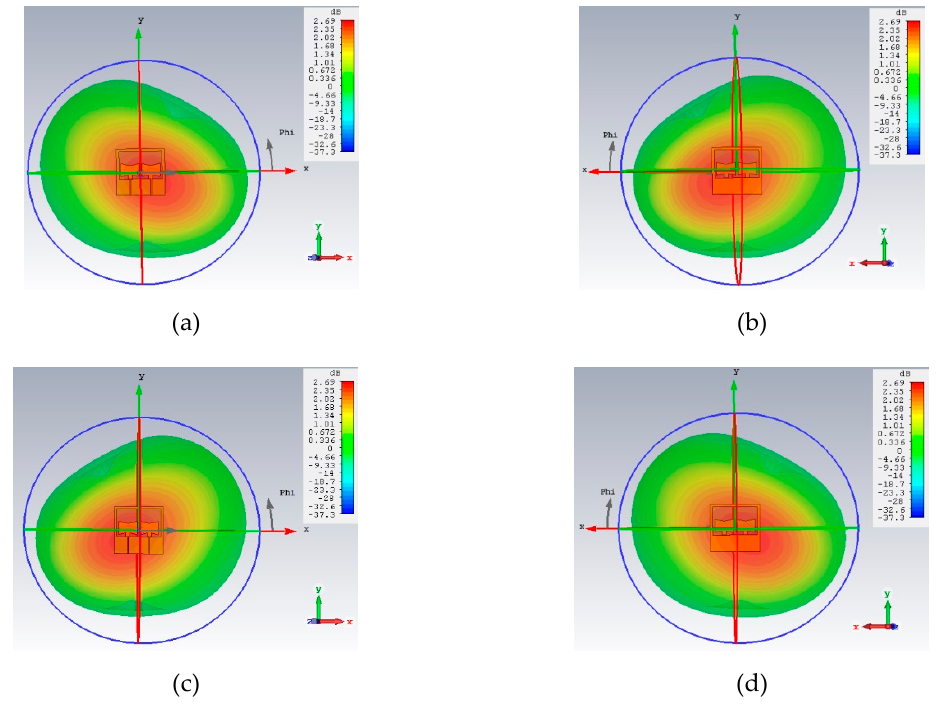
Figure 17. 3D Gain patterns at 868 MHz: ( a ) and ( b ) in front of and back of the antenna plane when port p1 is fed, ( c ) and ( d ) respective results when port p2 is fed.